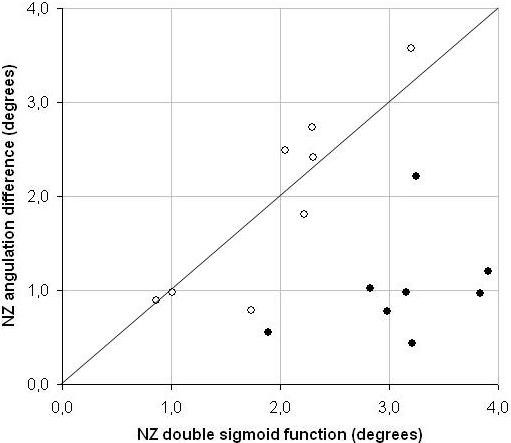
Scatter plot of the Neutral Zone magnitudes. The NZ calculated by the double sigmoid function (x-axis) as compared to the angulation difference as defined by Wilke (y-axis). Before the conditioning by continuous axial compression, the NZ as determined with the double sigmoid function is considerably larger than the angulation difference (closed circles). After a seven hours compression period, the values are more comparable (open circles). The thin line represents identity.